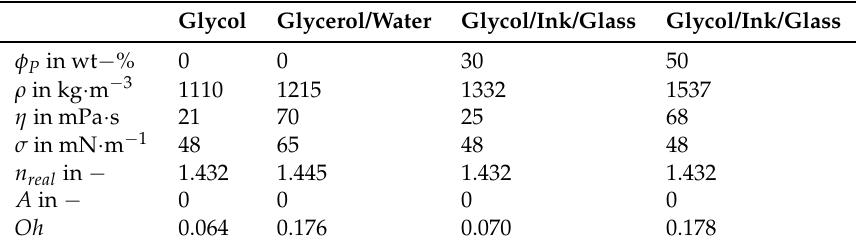
Table 1. Summary of the measured fluid properties—the measurements were performed at T = 20 ◦ C and p = 1